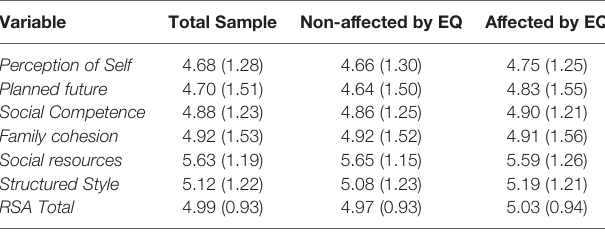
TABLE 2 | Resilience levels in affected and non-affected.